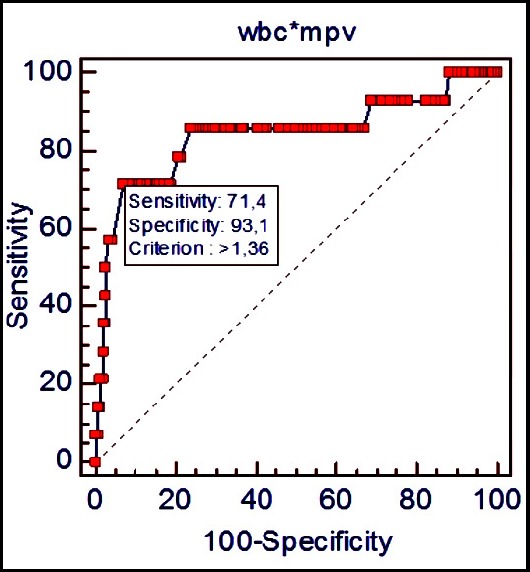
Sensitivity and specificity of WMR variable for predicting SYNTAX score ≥33.